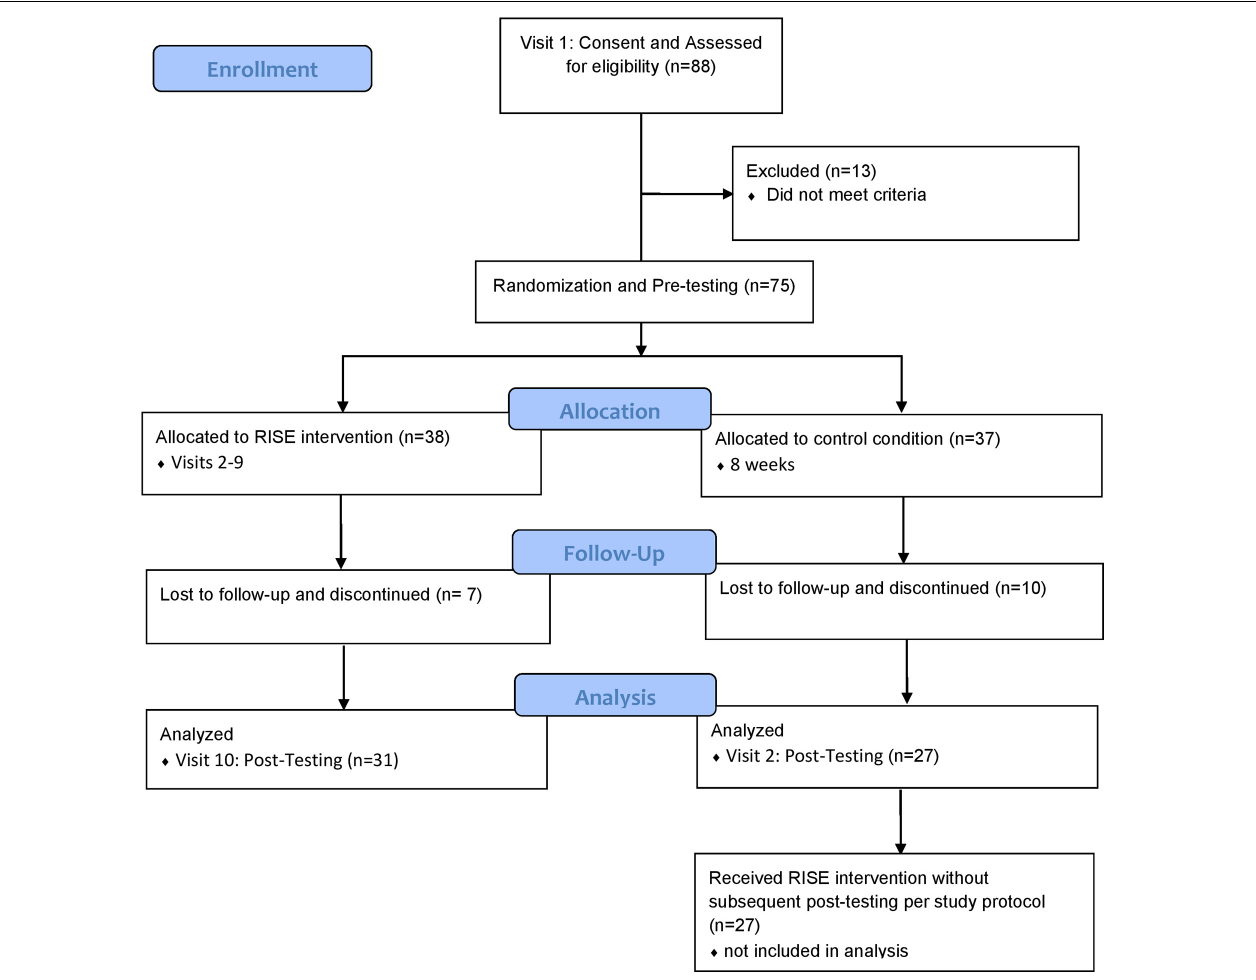
FIGURE 2 | CONSORT Flow